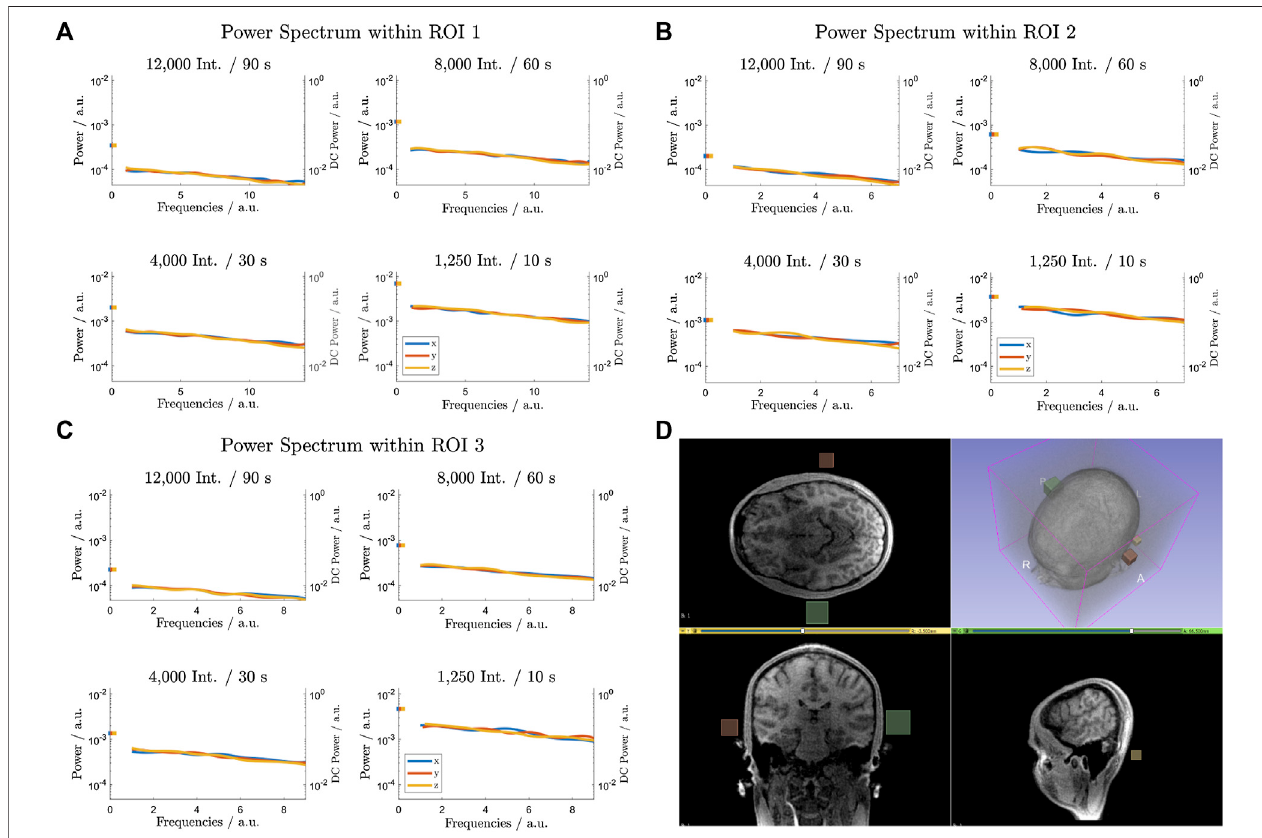
FIGURE 5 | Reconstructed axial and sagittal slices from an in-vivo 3D ζ -based Spiral acquisition. The undersampling factor increases from top to bottom. The calculated generalized FOV of each trajectory is indicated as red squares on the sagittal slices. The bottom line shows a Compressed Sensing reconstruction based on the acquisition with 1,250